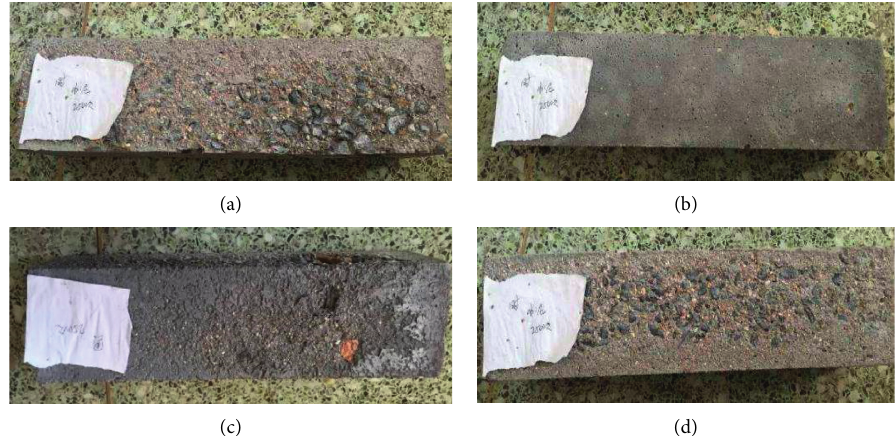
Figure 21: Tests on freezing resistance of three kinds of OSWA instead of cement and PC. (a) PPAC. (b) PC. (c) SAC. (d) GAC.